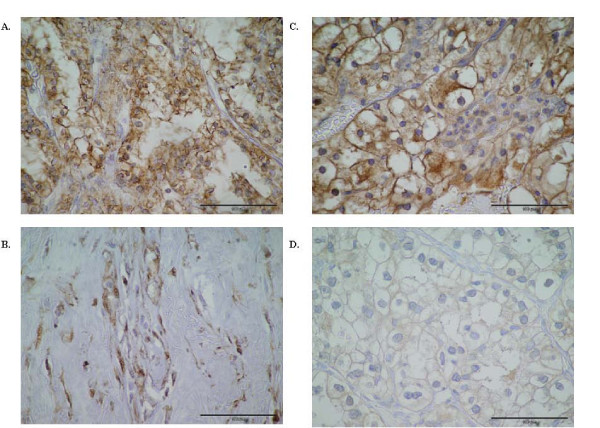
Immunohistochemical analysis of MDR-1 P-gp and MRP-1 protein expression in RCC. (A) RCC tumour showing positive MDR-1 P-gp staining with strong MDR-1 positivity observed, score (4+3) (scale bar = 100 μm) and (B) MDR-1 P-gp positive RCC with moderate positivity observed, score (2+2) (scale bar = 100 μm) (C) MRP-1 positive tumour showing intense MRP-1 positive staining, score (4+3) (scale bar = 100 μm) and (D) MRP-1 positive RCC with moderate positivity observed, score (2+2) (scale bar = 100 μm). (Original magnifications of all photomicrographs ×40).